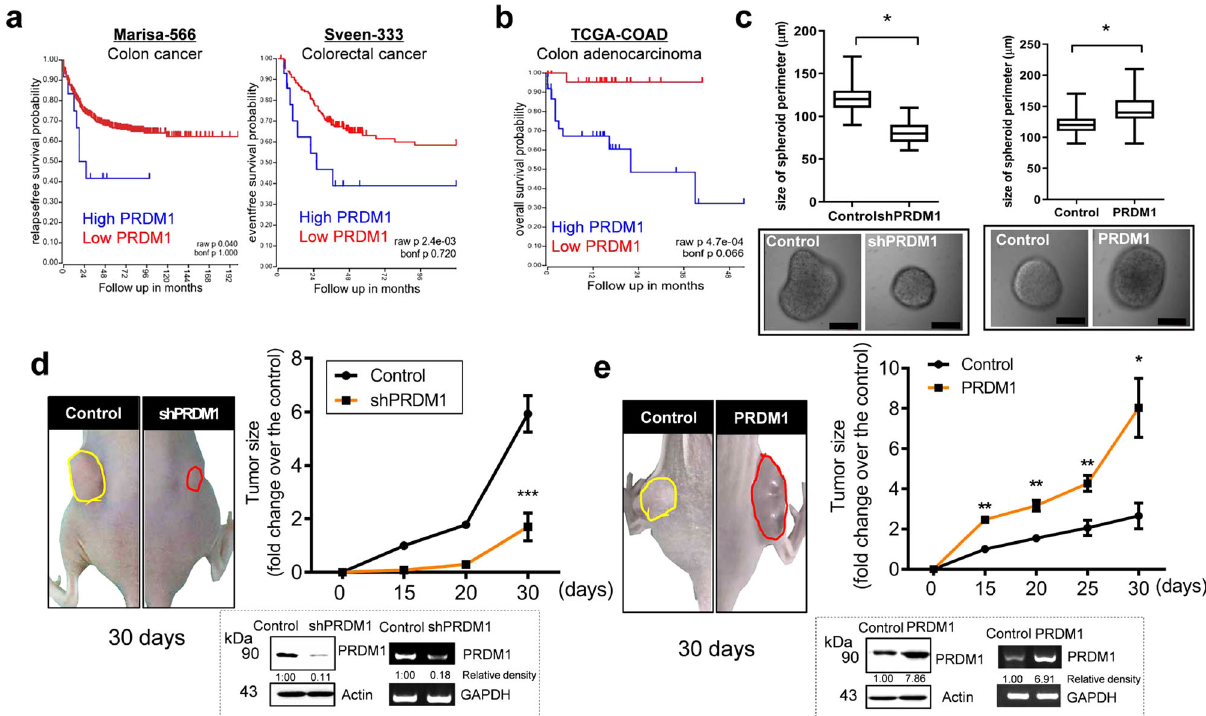
Fig. 1 PRDM1 expression and roles in CRC. a Kaplan – Meier plot of survival analysis based on tissue PRDM1 transcript levels in the patients with the colon cancer (left, Marisa ’ s, GEO ID: gse39582, n = 557; high PRDM1 > 396.4, n = 12; low PRDM1 < 396.4, n = 545) and colorectal cancer (right, Sveen ’ s, GEO ID: gse24551, n = 320; high PRDM1 > 1073.1, n = 28; low PRDM1 < 1073.1, n = 292). b Kaplan – Meier plot of survival analysis based on PRDM1 expression level in patients with colon adenocarcinoma (TCGA-COAD, n = 155; high PRDM1 > 1.755, n = 60; low PRDM1 < 1.755, n = 95). c Control (the negative control shRNA or the empty vector pMX-IRES-GFP)-, shPRDM1-expressing HCT-8 (left) or PRDM1-overexpressing HCT-8 (right) (2 × 10 5 ) were seeded in the ultralow attachment 6-well plates and cultured for 6 days, after which 200 spheroids per group were randomly selected and their average diameters measured. Results are shown as box-and-whisker plots (min to max) and asterisks (*) indicate signi fi cant differences from the control ( n = 147, * P < 0.05 using two-tailed unpaired Student ’ s t test). The boxed images show representative spheroids. The microscopy analysis was performed at original magni fi cation ×400; scale bar(s), 50 μ m. d , e Control plasmid (the negative control shRNA ( d ) or pMX-IRES-GFP ( e ))-, shPRDM1 ( d )-, or PRDM1 ( e )- expressing HCT-8 (2 × 10 6 ) were subcutaneously injected into BALB/c nude mice (left). Tumor size in mice was measured at each time after injection (right). Results are shown as mean values ± SD and asterisks represent a signi fi cant difference relative to the control group at each time point ( n = 3, * P < 0.05, ** P < 0.01, *** P < 0.001). Figures in the box indicate PRDM1 protein and mRNA expression in injected cancer cells using western blot analysis or